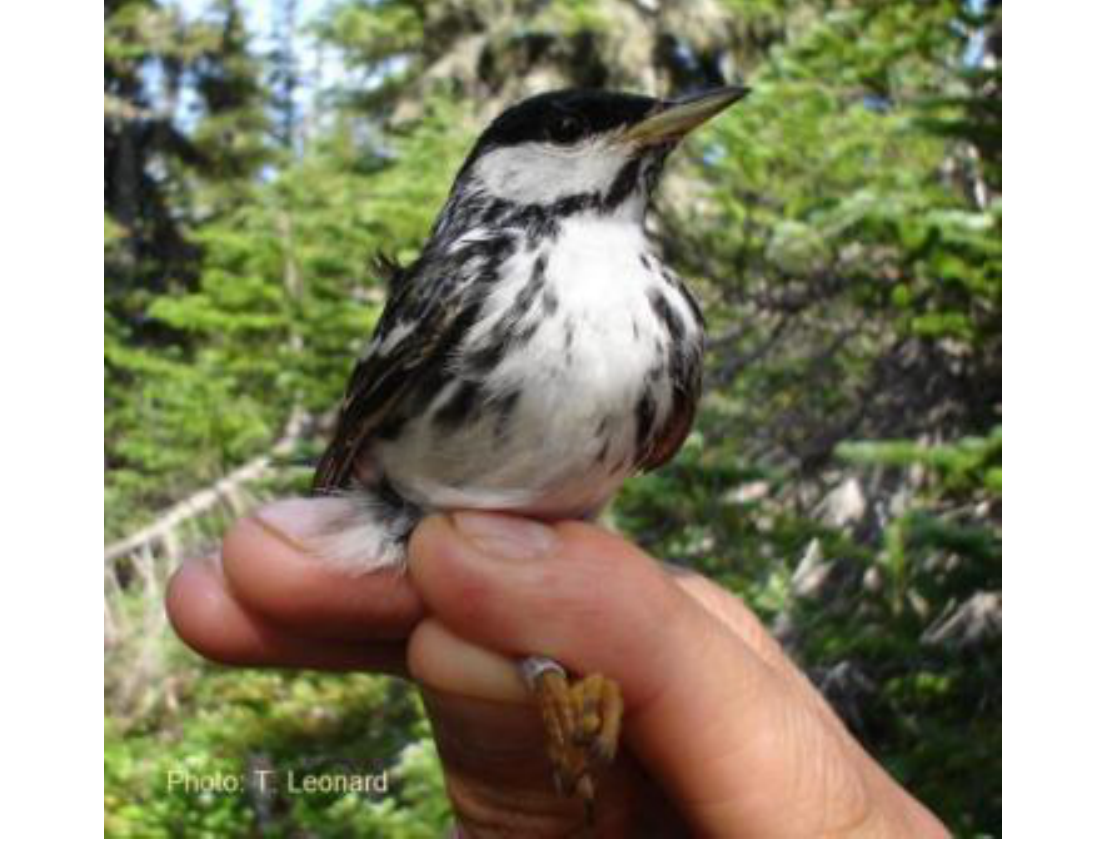
Fig. 3. This male Blackpoll Warbler was banded in a clearcut as an adult and recaptured one year later while on territory in a natural forest opening 820 m